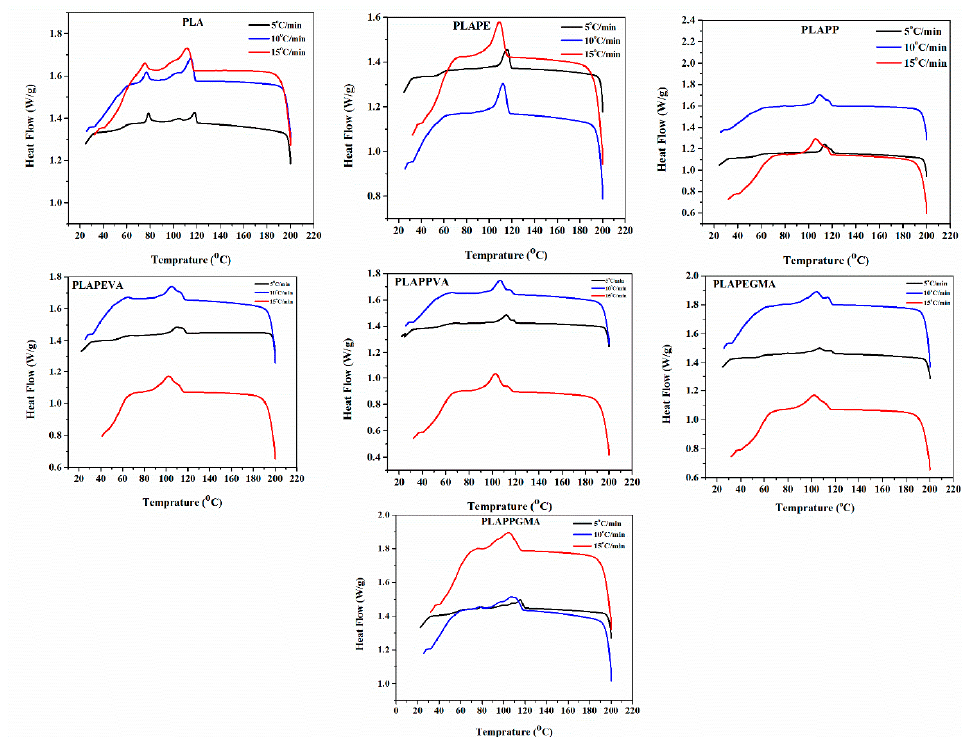
Figure 4. DSC thermograms of nonisothermal crystallization at different cooling rates for neat PLA and PLA/POE (80/20) with and without compatibilizer. Compatibilizers, EVA and EMA-GMA, were used at 4% phr. Table 2. Crystallization parameters of various PLA/POE blends at various cooling rates derived from nonisothermal DSC measurements.